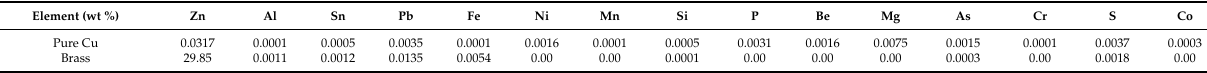
Table 1. Chemical composition of the pure Cu and brass tubes (in wt %).